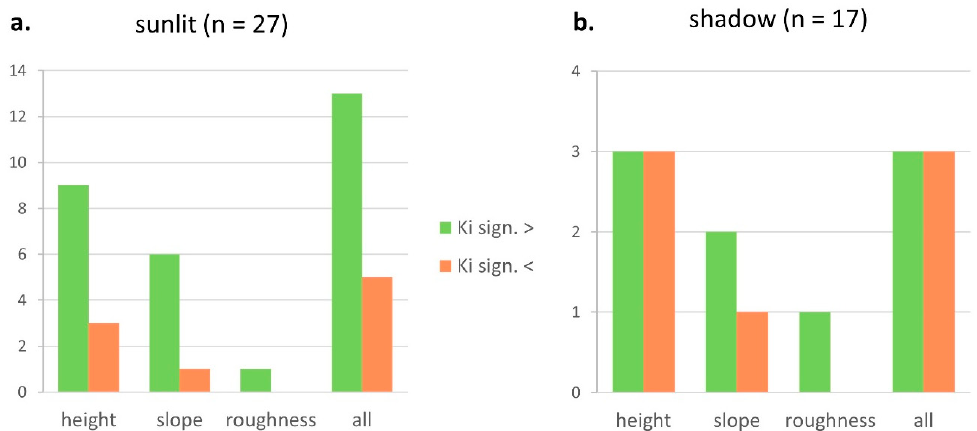
Figure 11. Number of land-cover classes with significantly higher and lower conditional kappa value after LiDAR post-classification correction, compared to before correction, in ( a ) sunlit and ( b ) shaded areas.